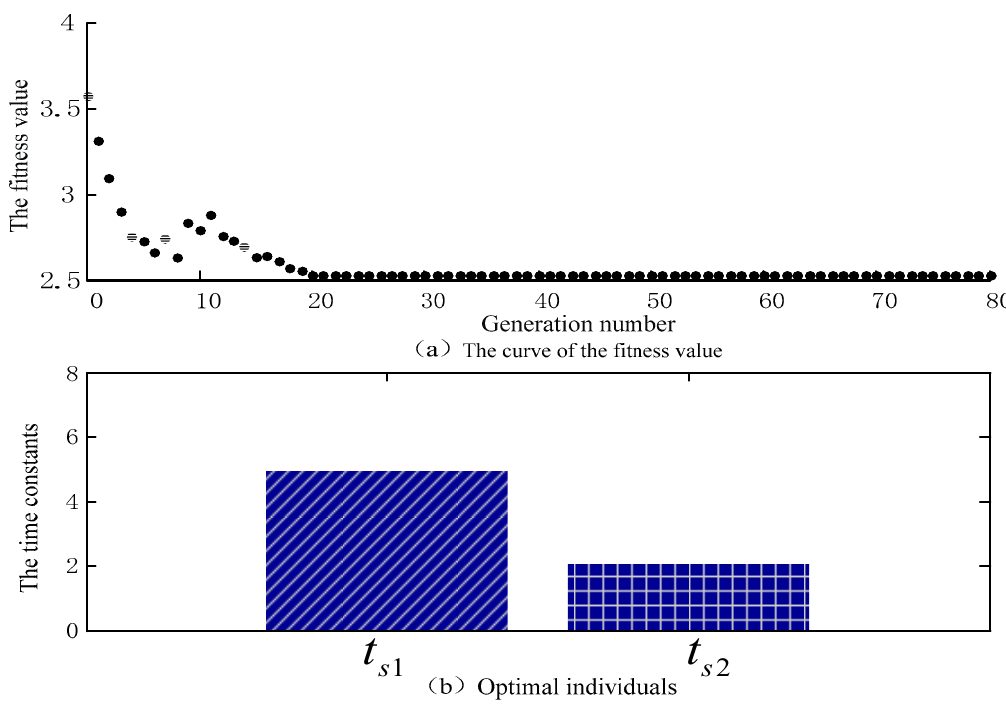
Figure 20. The optimization result obtained with a genetic algorithm (GA).